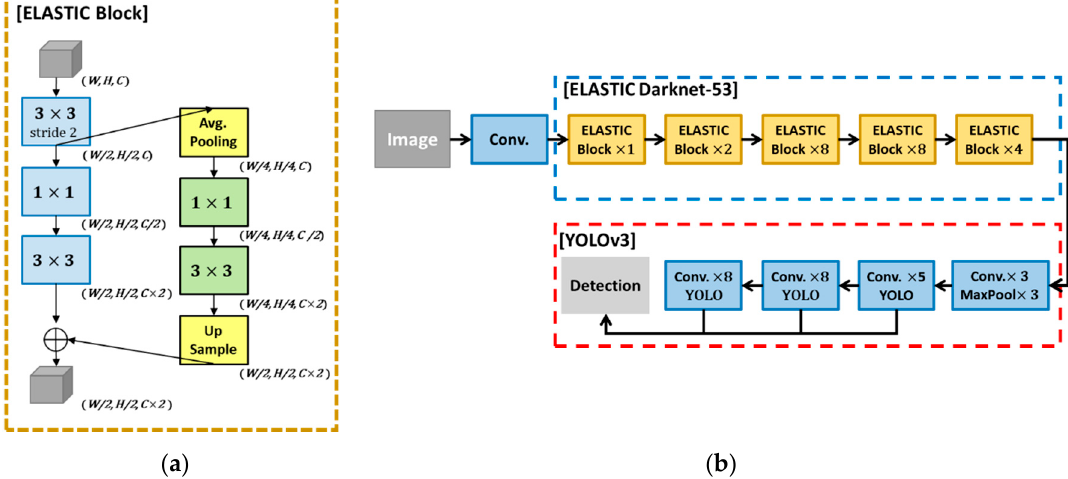
Figure 3. ELASTIC-YOLOv3 structure with proposed ELASTIC block. ( a ) The elastic block was upsampled from the average pooled input along Path 2 through two convolutions at low resolution and concatenated back to the original resolution, and ( b ) an ELASTIC-YOLOv3 structure with an ELASTIC block was coupled to Darknet-53, which is YOLOv3’s base network. The symbol × indicates the number of repetitions of the block.